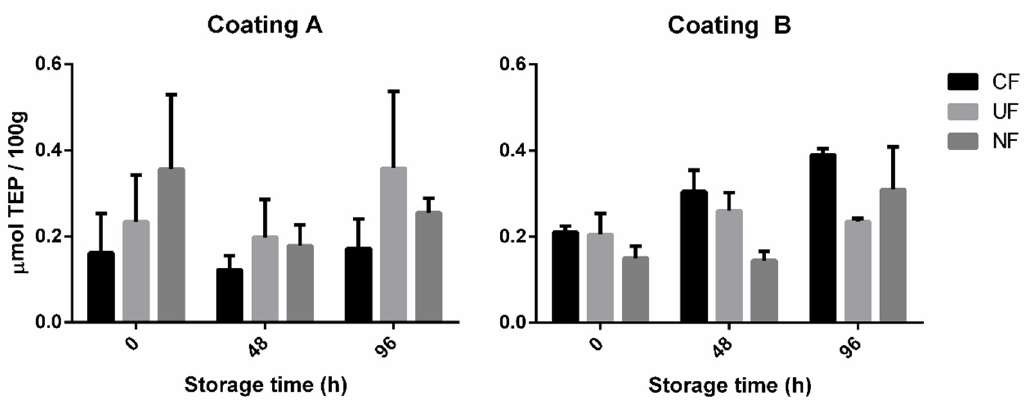
Figure 7. Concentration of thiobarbituric acid reactive substances present in the poultry samples treated with (CF) coated PP film, (UF) uncoated PP film, (NF) no film. Coating A = 5 wt% P. dioica extract and 7.5 wt% PVA. Coating B = 1 wt% P. dioica extract, 1 wt% PVA, and 17 wt% gelatine. Results presented as the average of three samples (n = 3). No statistical differences were detected in the pool of tested samples.